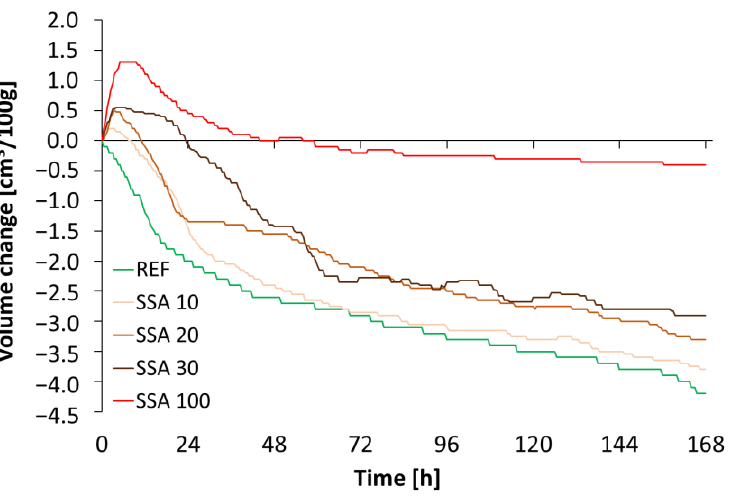
Figure 6. Chemical shrinkage of cement binders containing SSA additive.